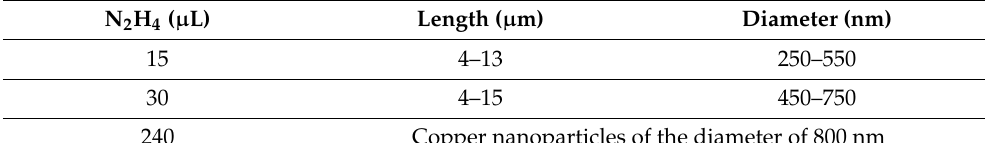
Table 1. Dimensions of copper nanowires synthesized with various amounts of N 2 H 4